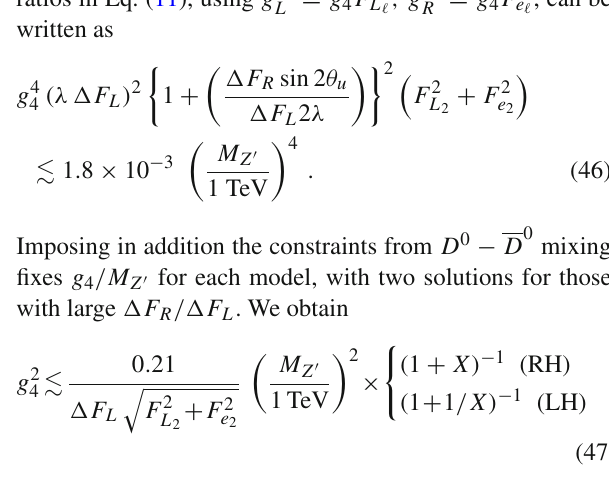
In Table 5 we present sample scenarios of Z (cid:3) –models with sizable BSM coefficients, which obey Eq. (39). The mod- els differ in their charge assignments, all of which fulfill anomaly cancellation conditions, see App. C for details.